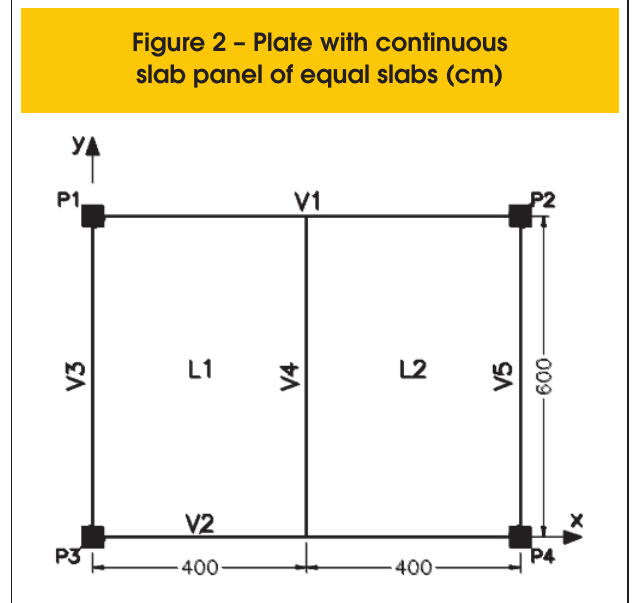
Figure 3 – Relationship between the height ( ) of V4 beam and I index